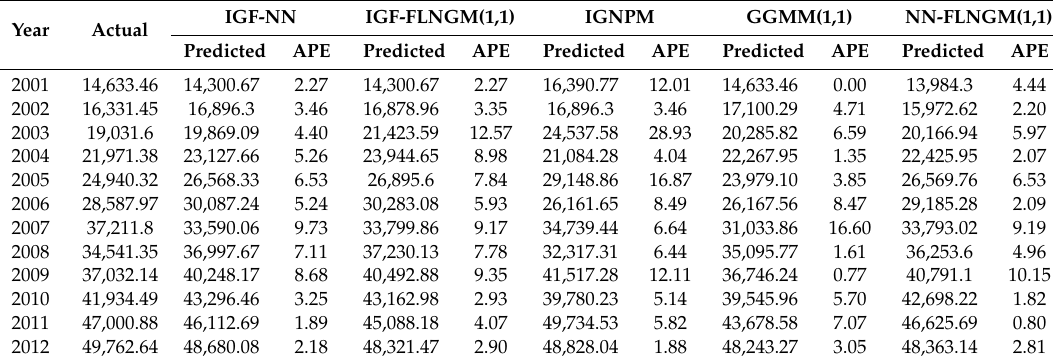
Table 1. Forecasting accuracy of di ff erent interval grey number forecasting models for Case I (unit: 100 million